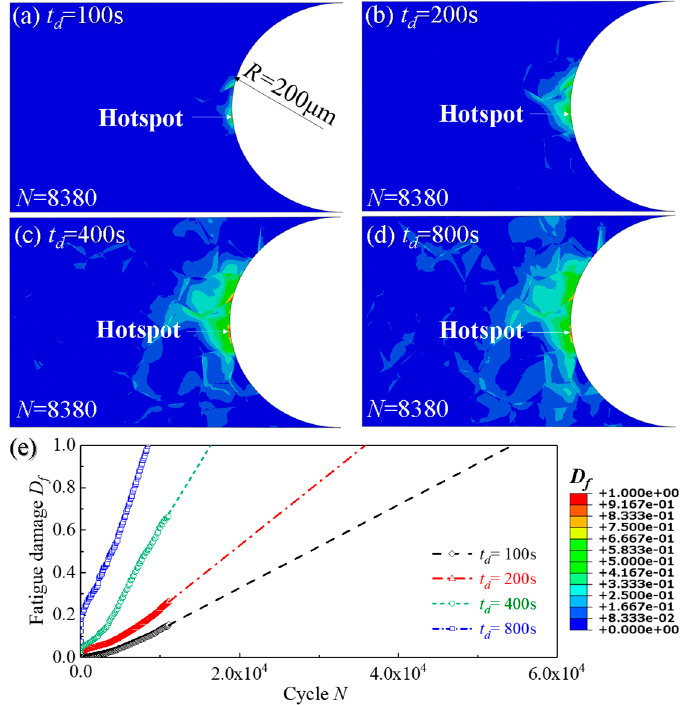
Figure 13. Distribution of fatigue damage of notch specimens for four different holding time: ( a ) t d = 100 s; ( b ) t d = 200 s; ( c ) t d = 400 s; ( d ) t d = 800 s and ( e ) the evolution curves of fatigue damage D f of hotspots from ( a – d ).